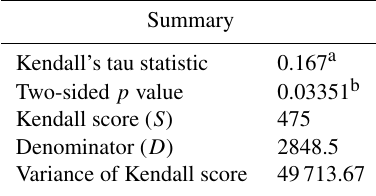
Table 1. Classes of flood hazard for mapping. Table 2. Results of Mann–Kendall